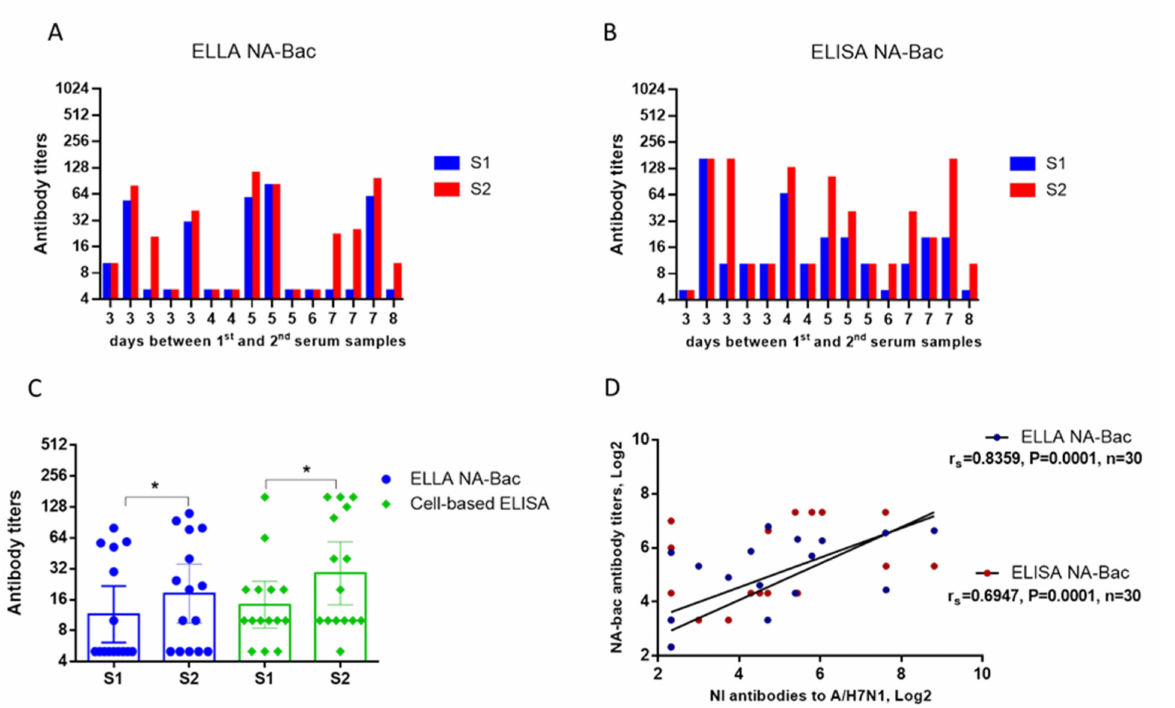
Figure 5. NA antibody titers of the paired sera from patients (n = 15) with a confirmed influenza infection were determined by an ELLA using N1-Bac and an N1-cell ELISA. S1—sera obtained on admission to the hospital. S2—sera obtained on days 3–8 after hospitalization. ( A ) NI antibody titers in the individual sera determined by an ELLA using N1-Bac. ( B ) NA antibody titers in the same batch of sera were determined by an N1-cell ELISA. ( C ) Mean geometric titers of NI and ELISA antibodies. Each dot represents a subject (n = 15). Dashes indicate GMT values. *— p < 0.05. ( D ) Correlation analysis of NI antibody titers determined using A/H7N1 influenza virus to NA-Bac antibodies determined by N1-Bac-ELLA and N1-cell ELISA (Spearman’s